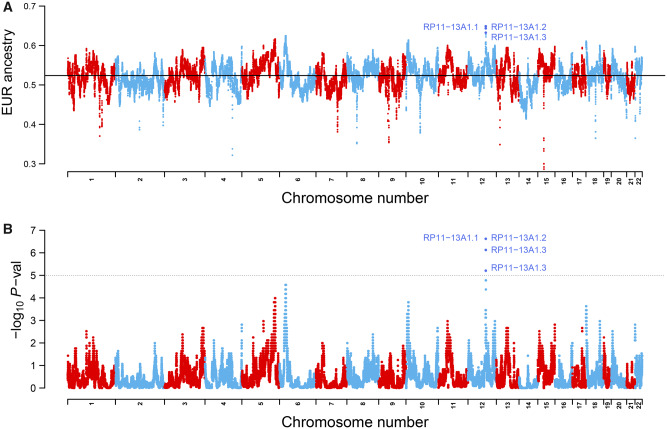
Genome-wide deviations in the local mean European ancestry among Chileans. (A) Deviations in the mean local European ancestry over the genome-wide mean along autosomes. The black horizontal line represents the genome-wide local European ancestry mean (0.521) (B). t-Test P values of the deviations expressed as −log10P value. The dotted black line represents the cutoff threshold of P < 10−5 for SDs (Bhatia et al. 2014). Highlighted are genes associated with variants significantly enriched in European ancestry.